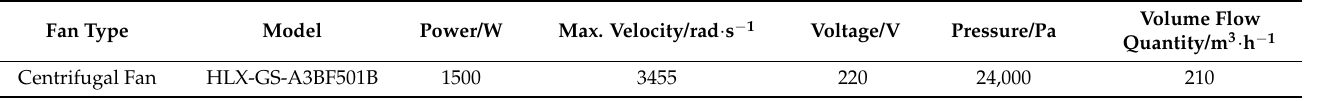
Table 1. Parameters of the small centrifugal